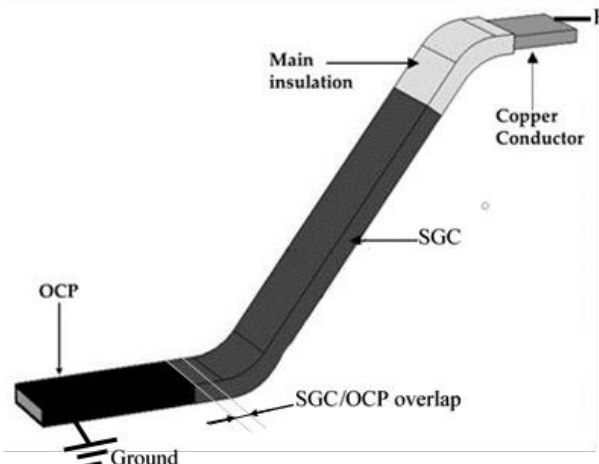
Figure 1. Illustration of the insulation system of a typical stator bar used in large high-voltage (HV) hydro-generators.